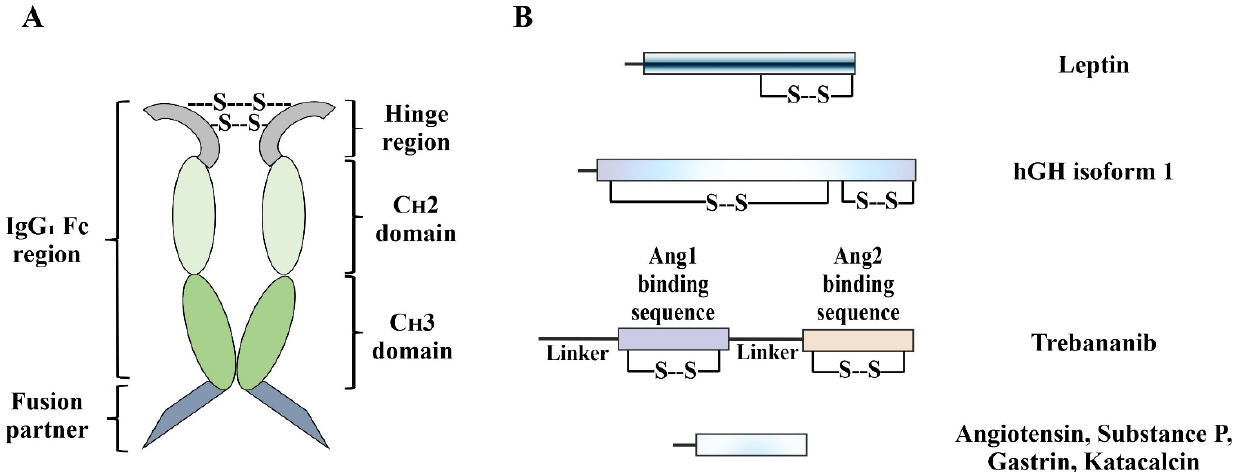
Figure 1. ( A ) Schematic representation of an IgG 1 ‐ based Fc fusion protein. The IgG 1 Fc domain is a natural homodimer consisting of three parts: the hinge region, C H 2 domain and C H 3 domain. Cova ‐ lent interactions in the hinge region (intermolecular disulfides) as well as non ‐ covalent interactions between the C H 3 domains facilitate the homodimerization of the IgG 1 Fc region. ( B ) Schematic rep ‐ resentation of the fusion partners used in the study and their disulfide ‐ bonding patterns (Ang1: Angiopoietin 1, Ang2: Angiopoietin 2). All the Fc fusion proteins used in this study have the partner hormone or peptide fused to the C ‐ terminus of the C H 3 domain.